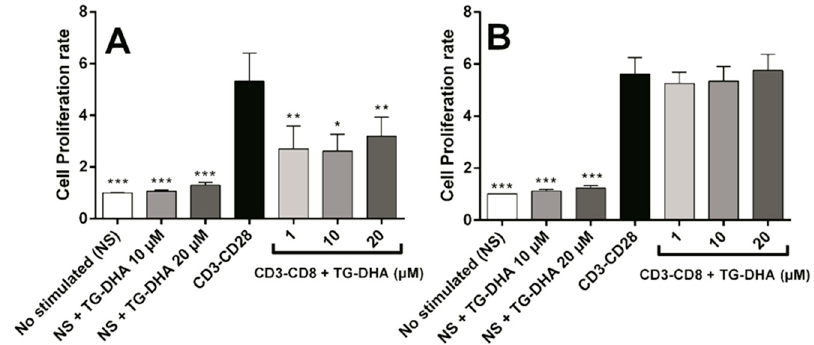
Figure 4. Effect of DHA on splenocytes and CD4+ T cells proliferation after anti-CD3/anti-CD28 lymphocyte stimulation. Splenocytes ( A ) and purified CD4+ T-cells ( B ) were isolated from mice and cultured in presence or absence of TG-DHA (1–20 µM). Proliferation assay was carried out after 72 h and determined using a commercial colorimetric bromodeoxyuridine (BrdU) cell proliferation kit. Proliferation rate was calculated as the absorbance of cells in the presence of anti-CD3-CD28 divided by the absorbance of cells in the absence of antibodies. * = p < 0.05; ** = p < 0.01; *** = p < 0.001.